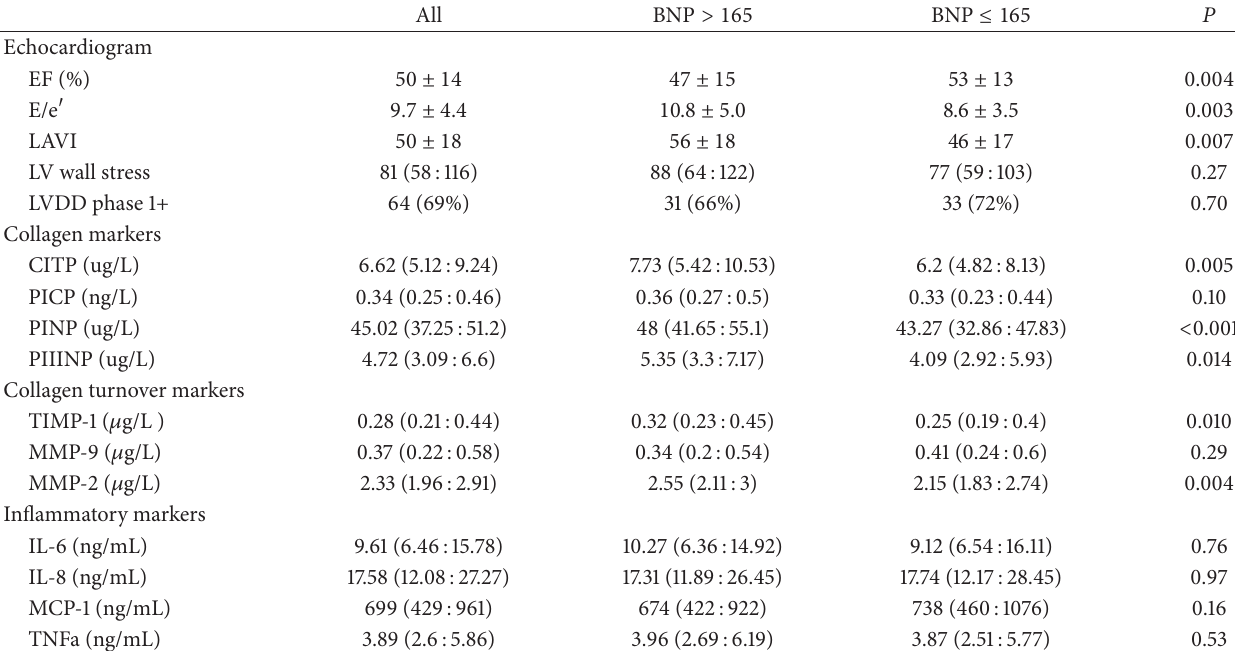
Table 2: Echocardiogram and collagen/inflammatory markers for total population and for population split by median BNP of 165pg/mL. All BNP > 165 BNP ≤ 165 𝑃